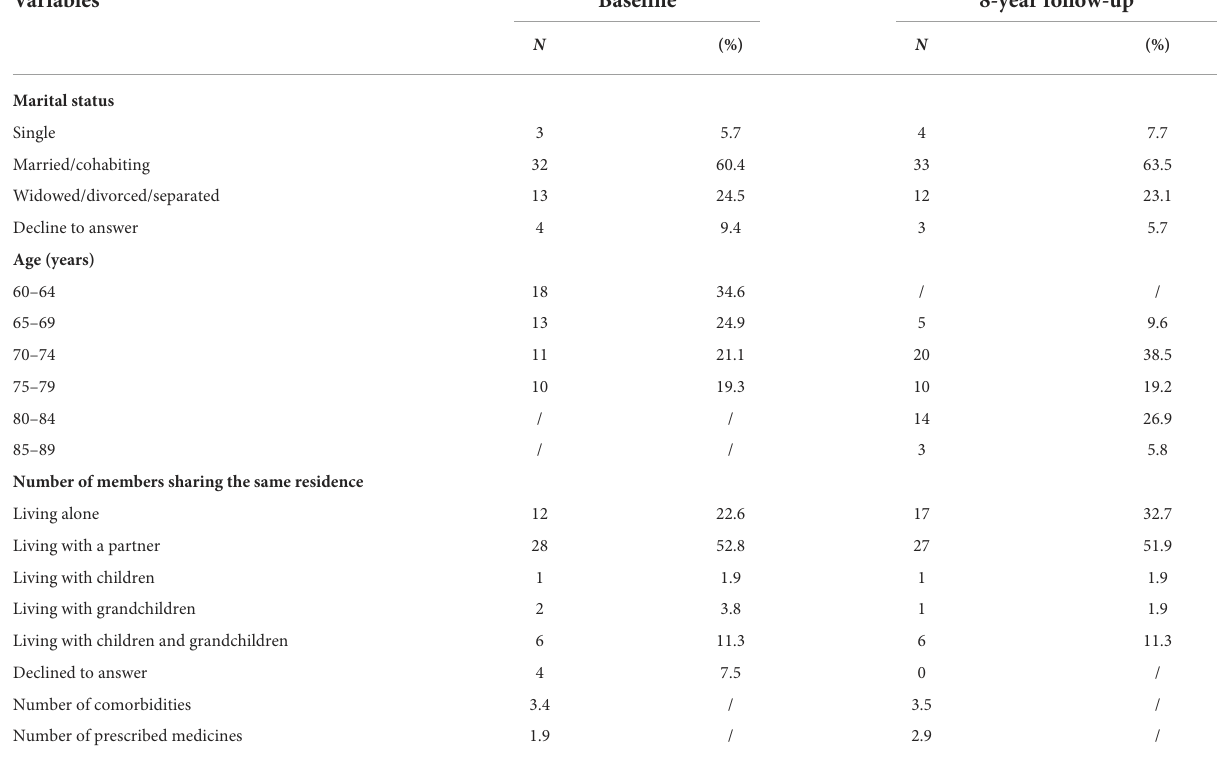
TABLE 2 Sample description on baseline and follow-up measurements.